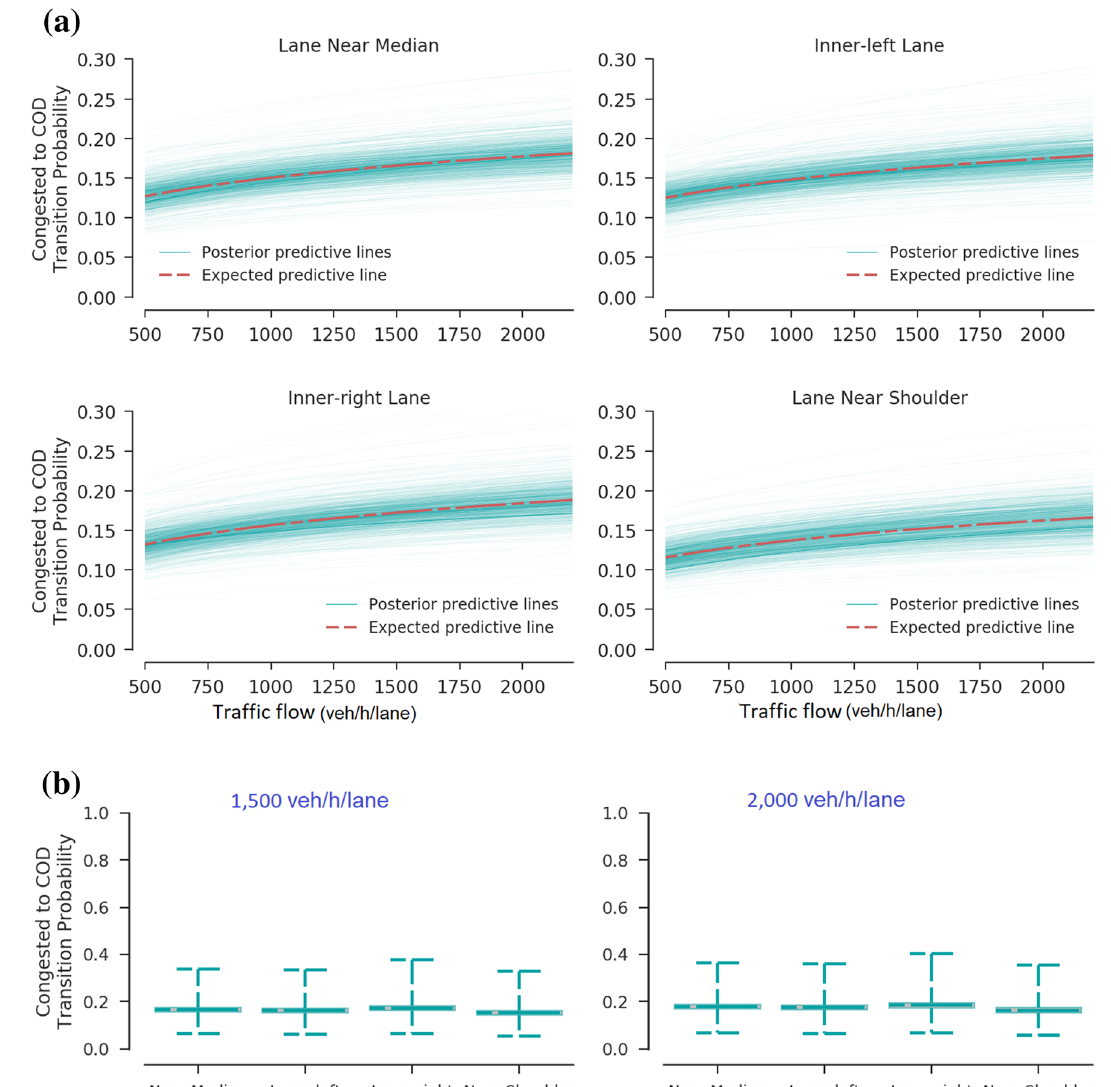
Fig. 6 Transition probability and flow rate relationship for Site 2. a Congested to COD transition probability versus flow rate. b Congested to COD transition probability across lanes at different flow